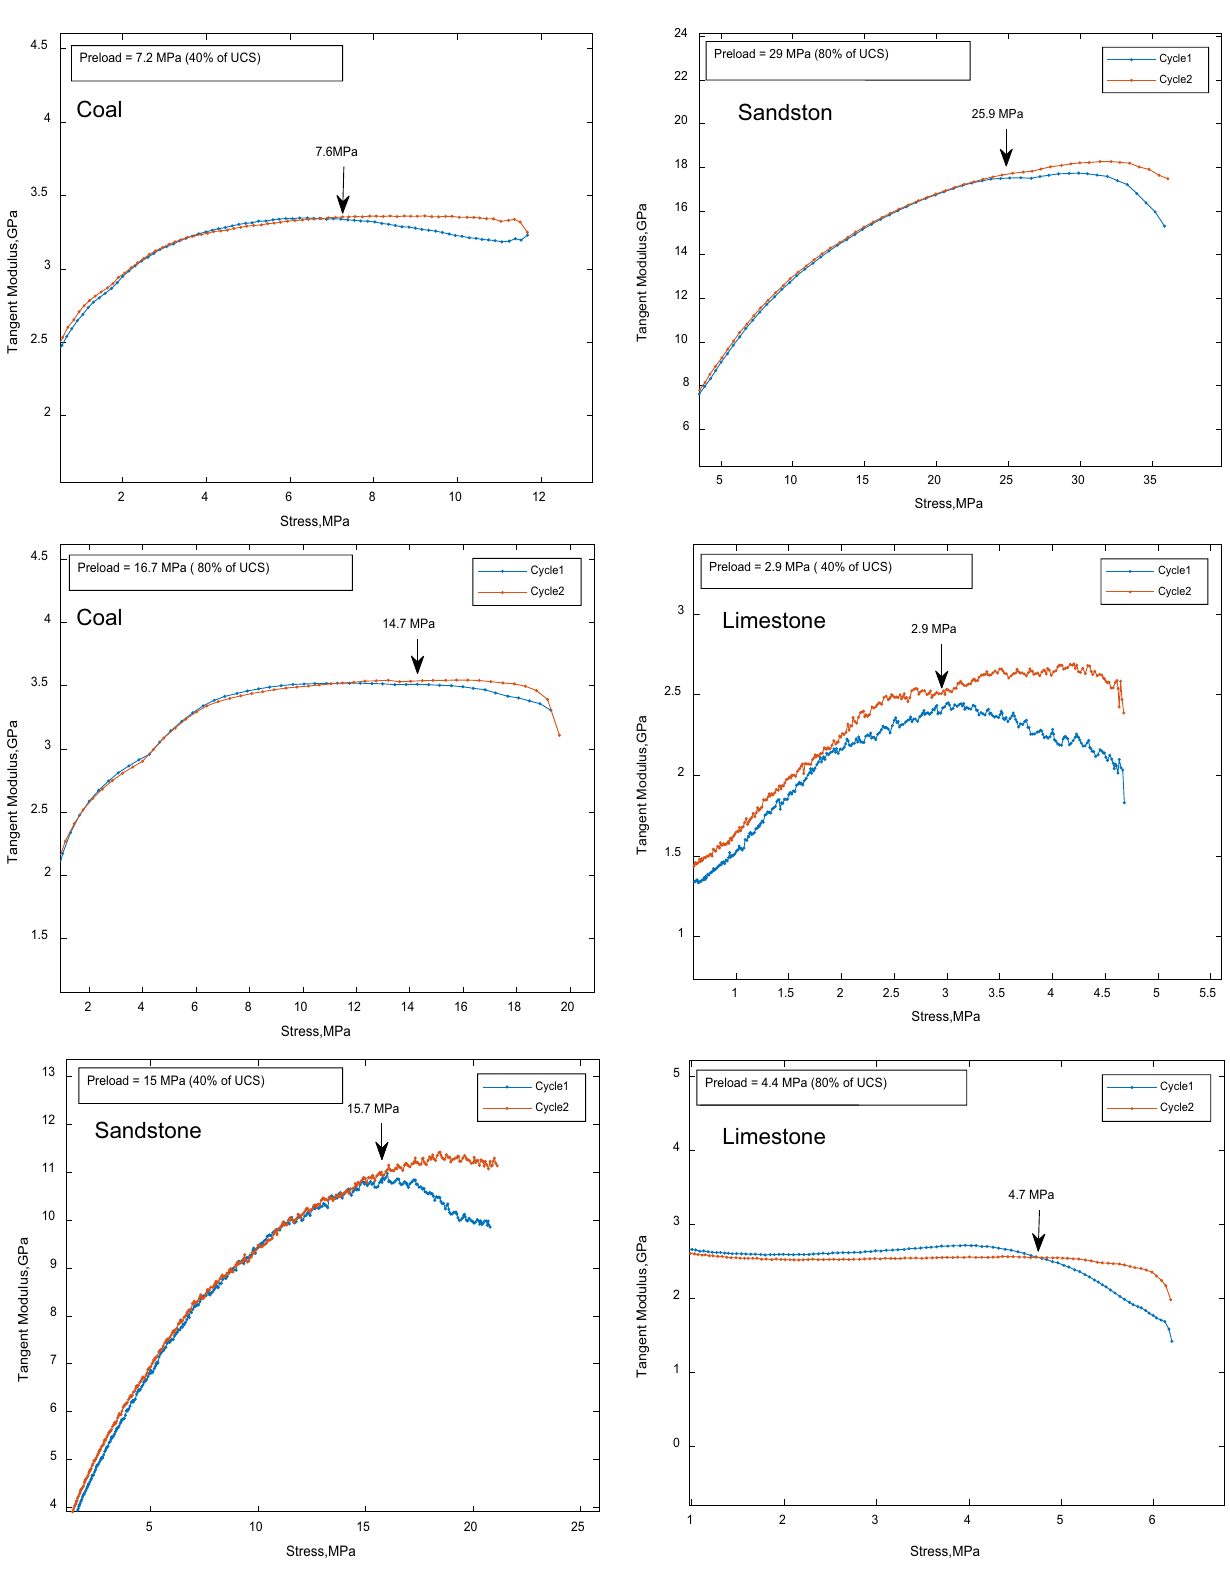
Fig. 9 Tangent modulus curves of coal, sandstone and limestone preloaded at approximately 40% and 80% of their compressive